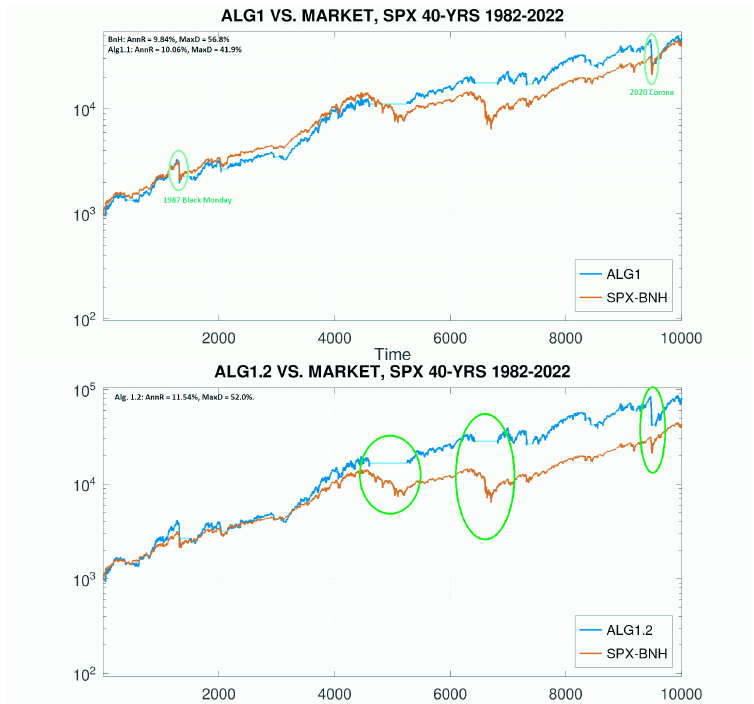
Figure 9. Performance of variations on Algorithm 1: ( top ) Algorithm 1.1 with leverage = 1.5 × and ( bottom ) Algorithm 1.2 with leverage = 2 × . Note that as we leverage more, we can realize gains, but the Black Swan events are also magnified. Therefore, the desirable properties of increased gains and reduced drawdowns are a tradeoff, and Black Swan events are